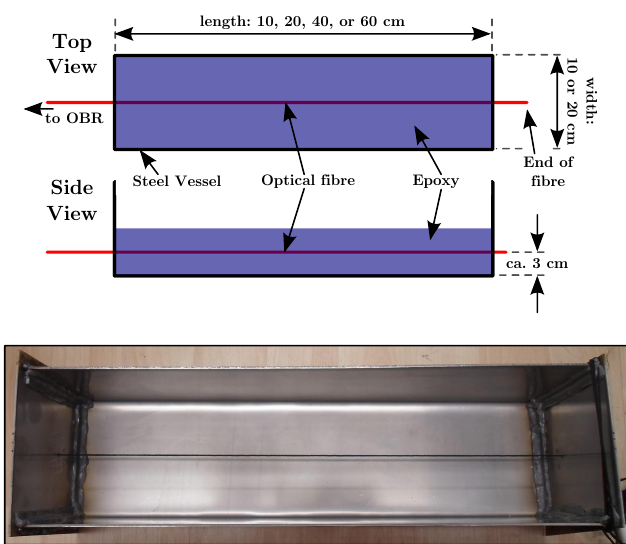
Figure 1. Schematic of the experimental setup for OBR measurements (upper image). Photo of an empty 40cm long steel mold (lower image). To visualize the position of the optical fiber, a black thread was added. It was taken out before the actual fiber was